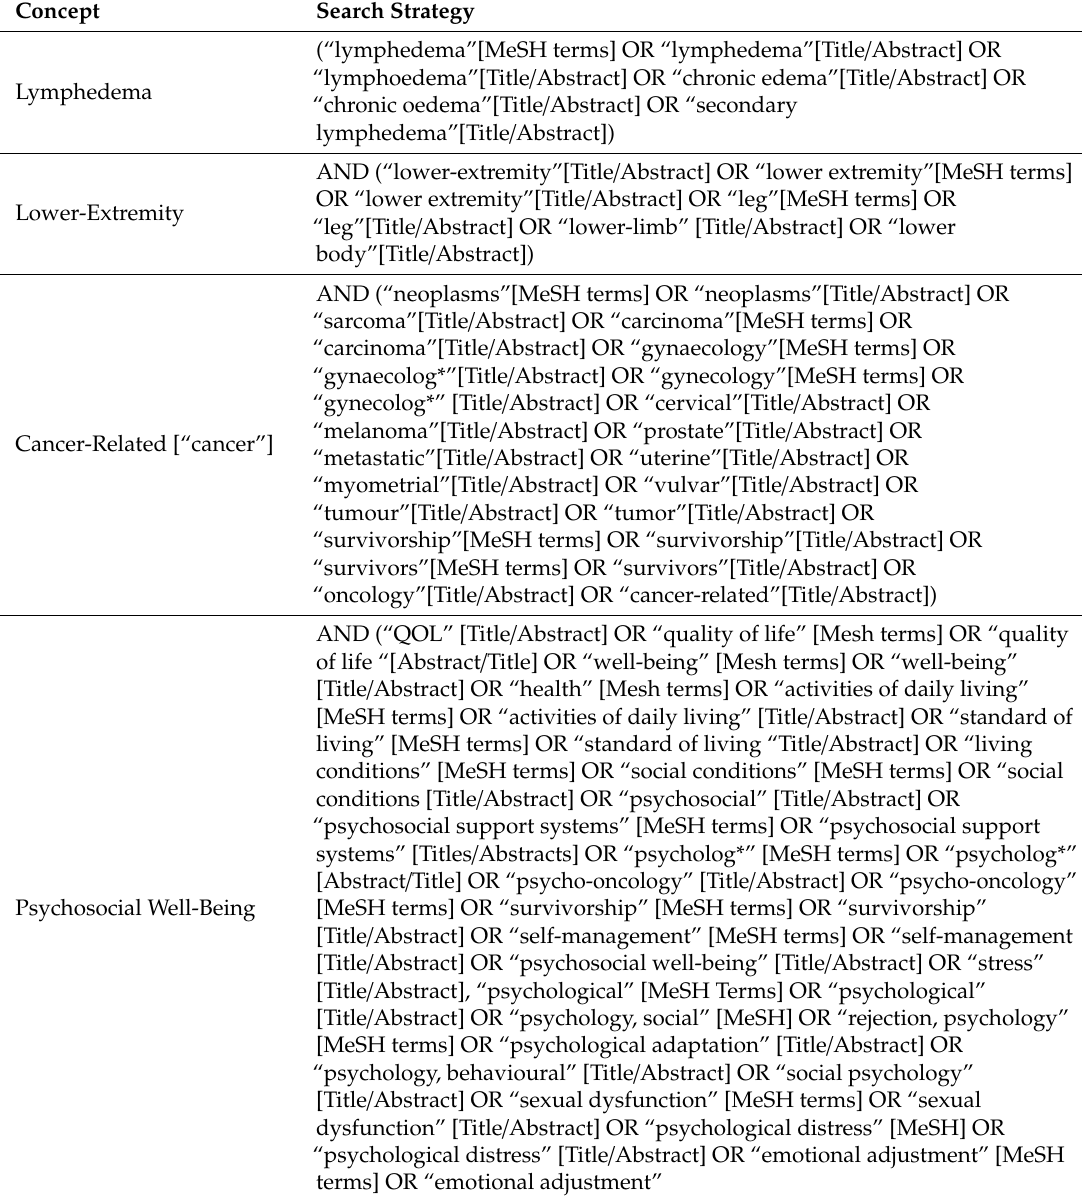
Table A1. Constructed search strategy for PubMed, which was adapted for other databases